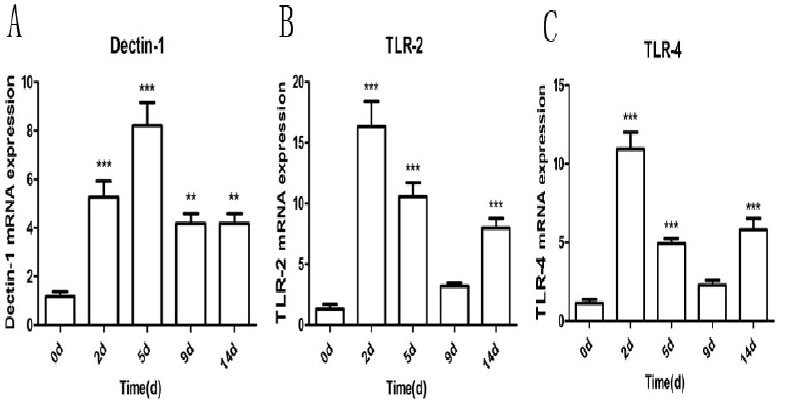
Figure 6. ( A – C ) M. gypseum (4 × 10 6 CFU/mL)-induced expression of selected receptor genes (Dectin- 1, TLR-2, TLR-4) detected by quantitative reverse transcriptase-polymerase chain reaction (qRT-PCR) in the lungs at 2, 5, 9, and 14 days after infection. The results are presented as mean ± SD and represent three individual experiments (n = 8 mice per group). ** p < 0.01; *** p < 0.001. 2.6. Quantification of Cytokine mRNA Levels in the Lung after M. gypseum Infection